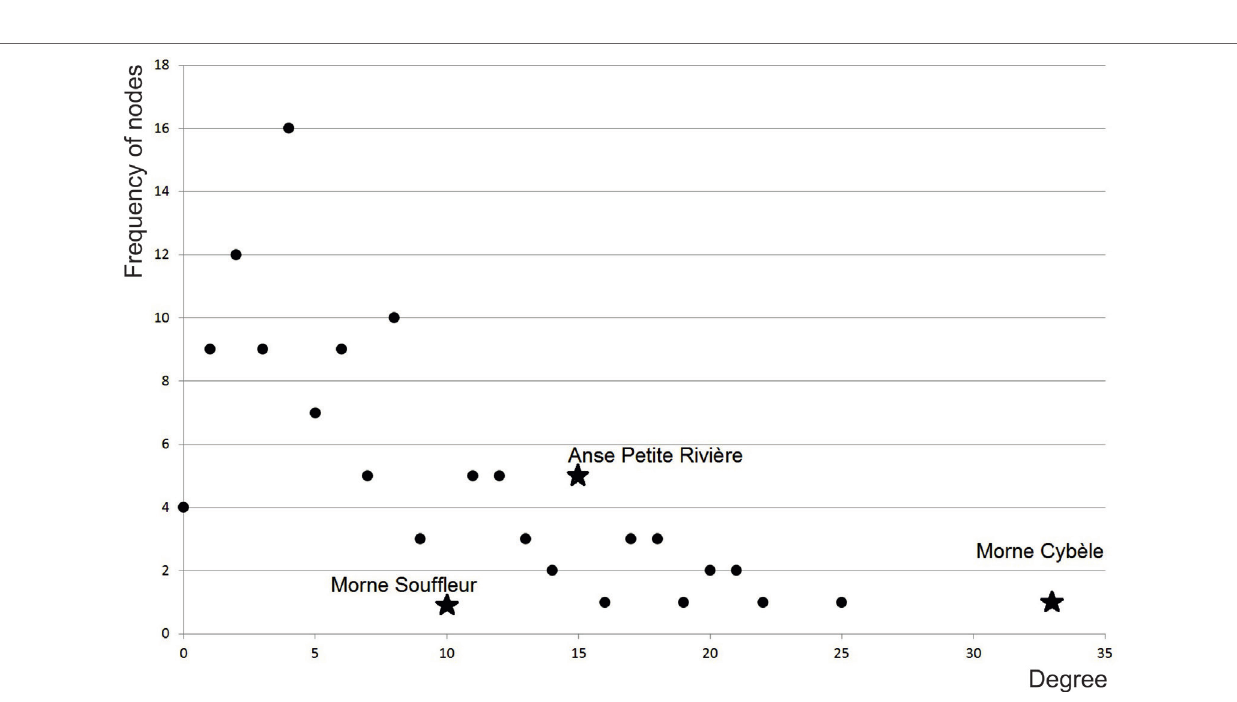
FigUre 5 | Degree distribution of visibility network representing total viewshed results shown in Figure 4 .